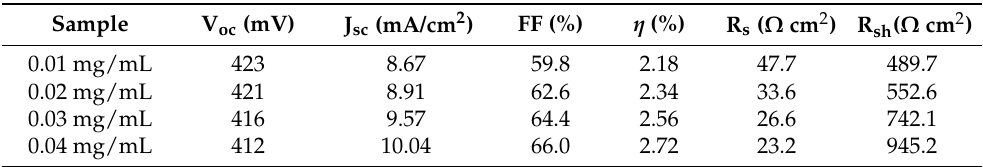
Figure 10. Current density–voltage (J–V) characteristics of the solar cell device with a glass/ITO/PEDOT:PSS/P 3 HT:PCBM:Sb 2 S 3 :NC/MoO 3 /Ag configuration. Table 1. Detailed photovoltaic parameters of the organic solar cell device under AM 1.5 sun illumina- tion with light power intensity of 100 mW/cm 2